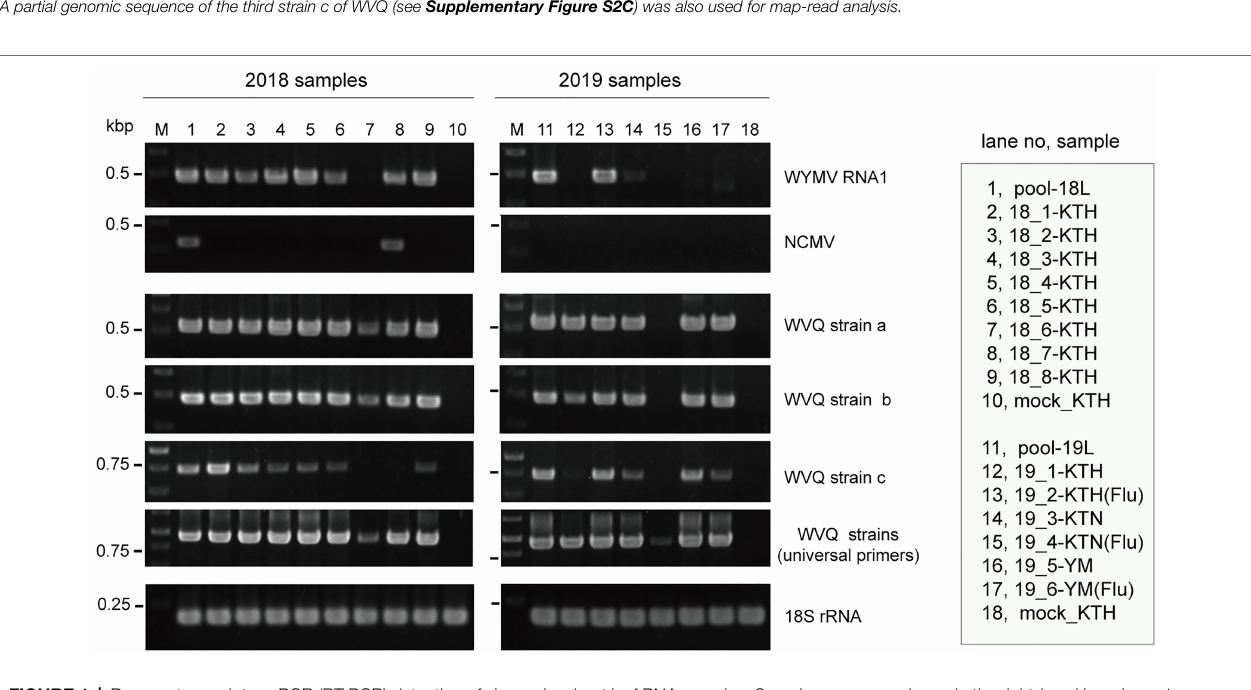
FIGURE 1 | Reverse transcriptase PCR (RT-PCR) detection of viruses in wheat leaf RNA samples. Sample names are shown in the right-hand box. Lane 1 (pool-18L) and lane 11 (pool-19L) are two pooled RNA samples subjected to NGS analysis. Lanes 10 and 18 are RNA samples of mock-inoculated plants. KTH,